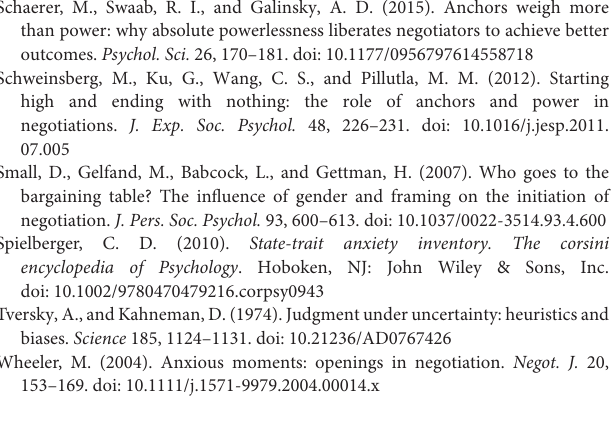
Conflict of Interest: The authors declare that the research was conducted in the absence of any commercial or financial relationships that could be construed as a potential conflict of